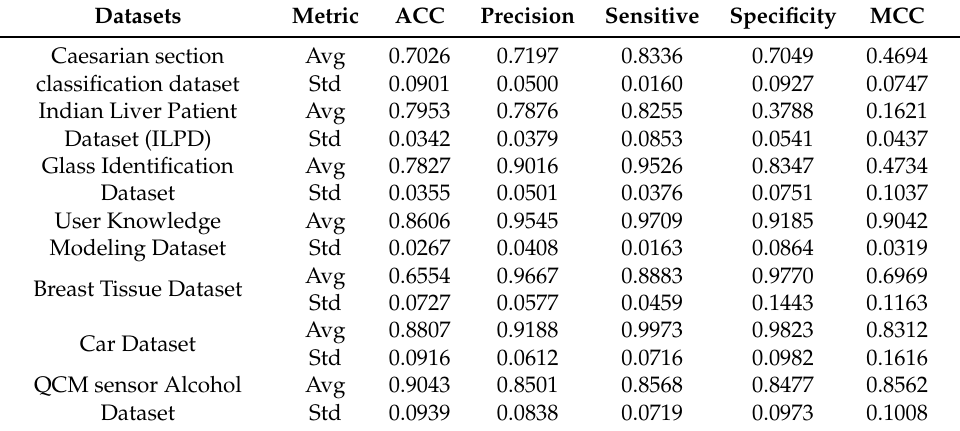
Table 7. Results of the hybrid-FKNN on multi-class datasets.